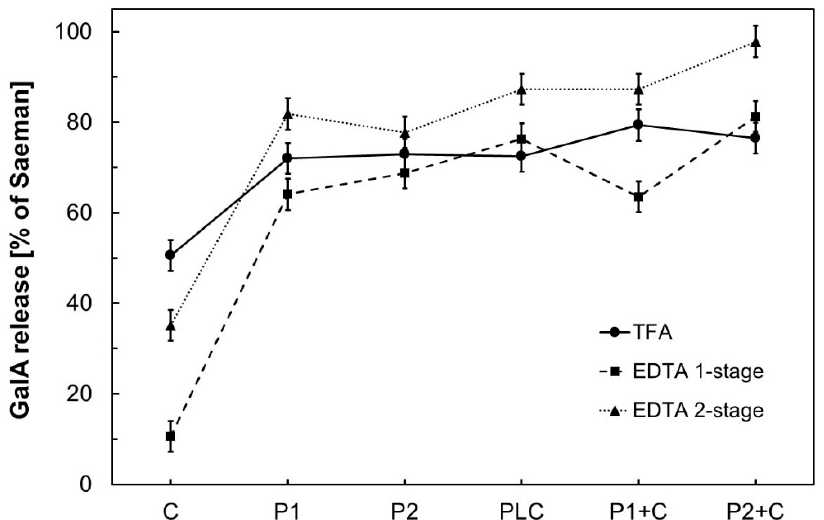
Figure 1. Release of galacturonic acid (GalA) in dependence of digestion method and applied enzyme (Table 1) in relation to Saeman hydrolysis (reference 100%). Results are based on analysis of variance (ANOVA) (mean ± least significant difference (LSD)).